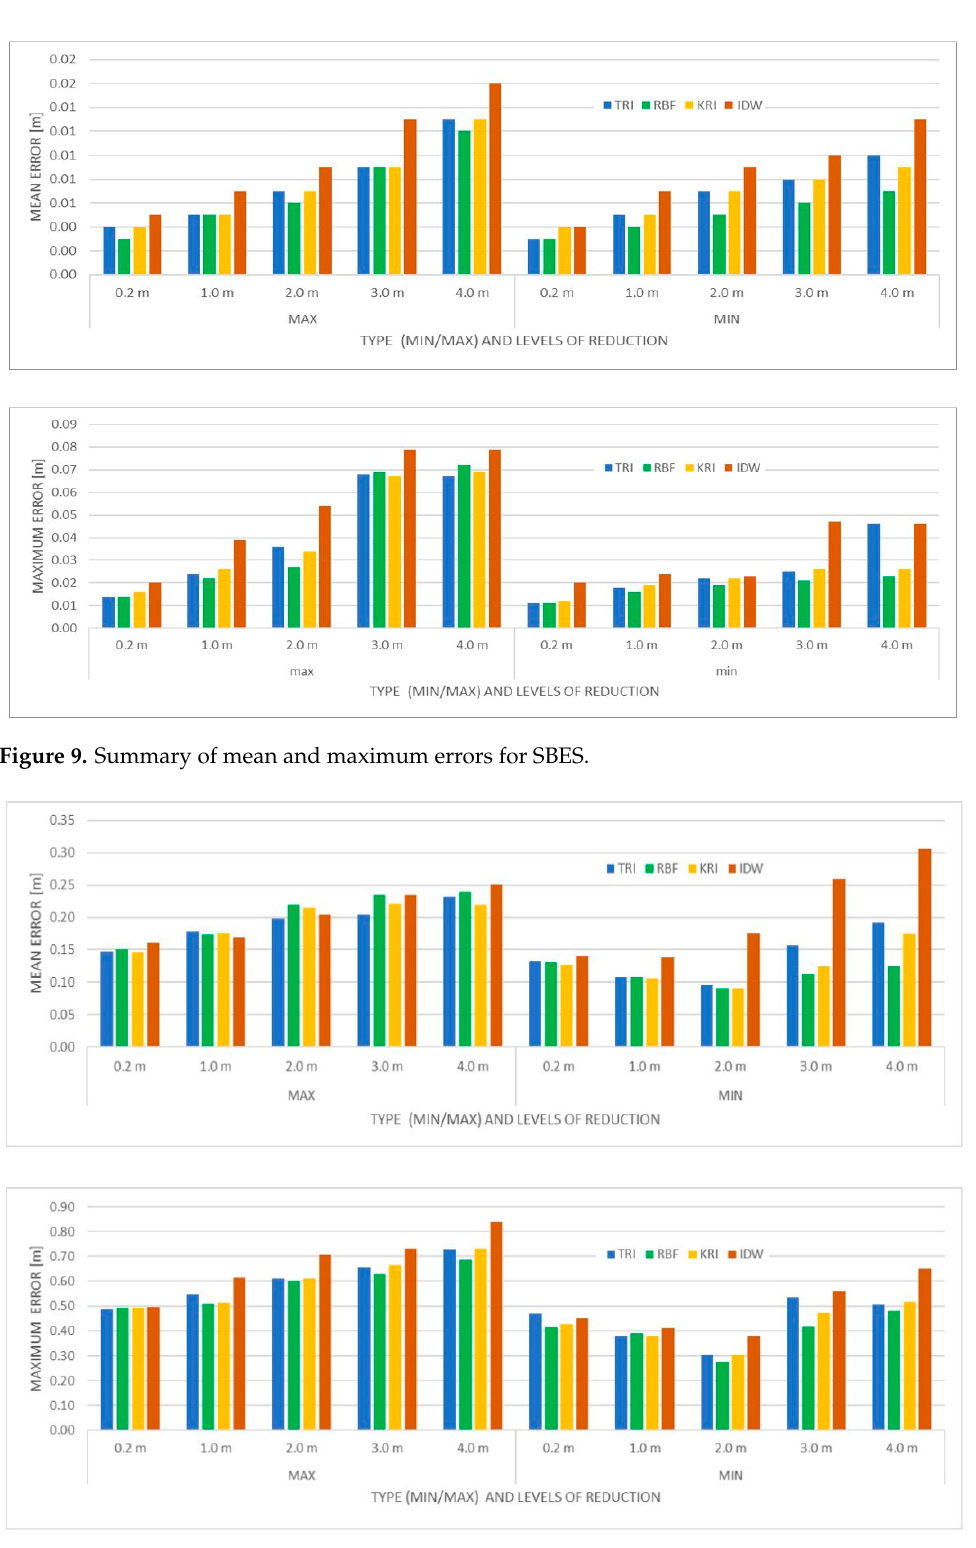
Figure 10. Summary of mean and maximum errors for UAS.